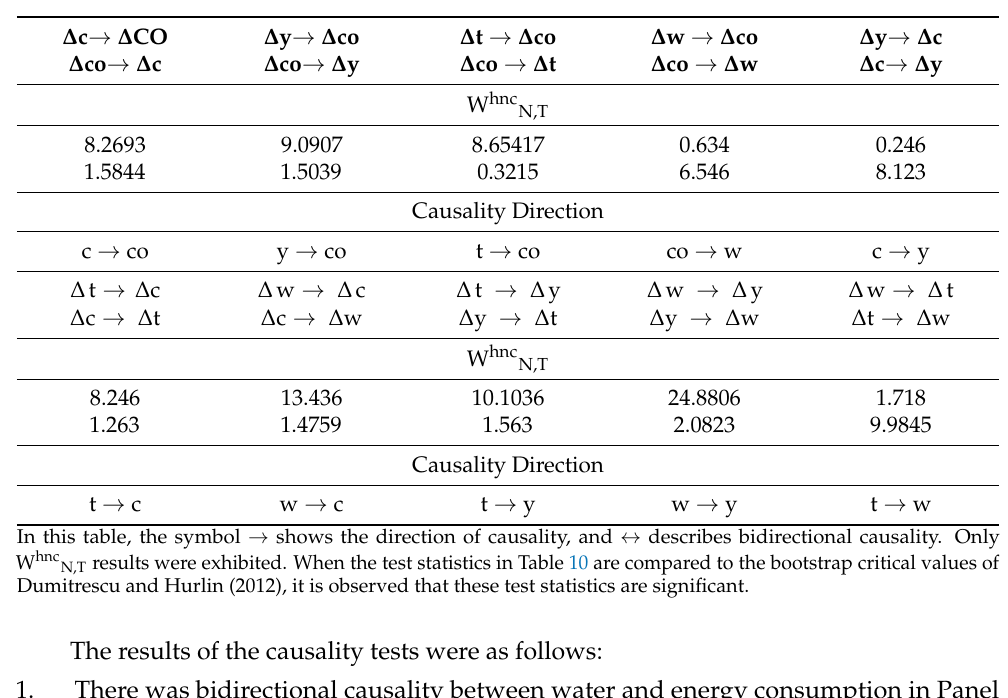
Table 10. Results of the Dumitrescu–Hurlin panel causality